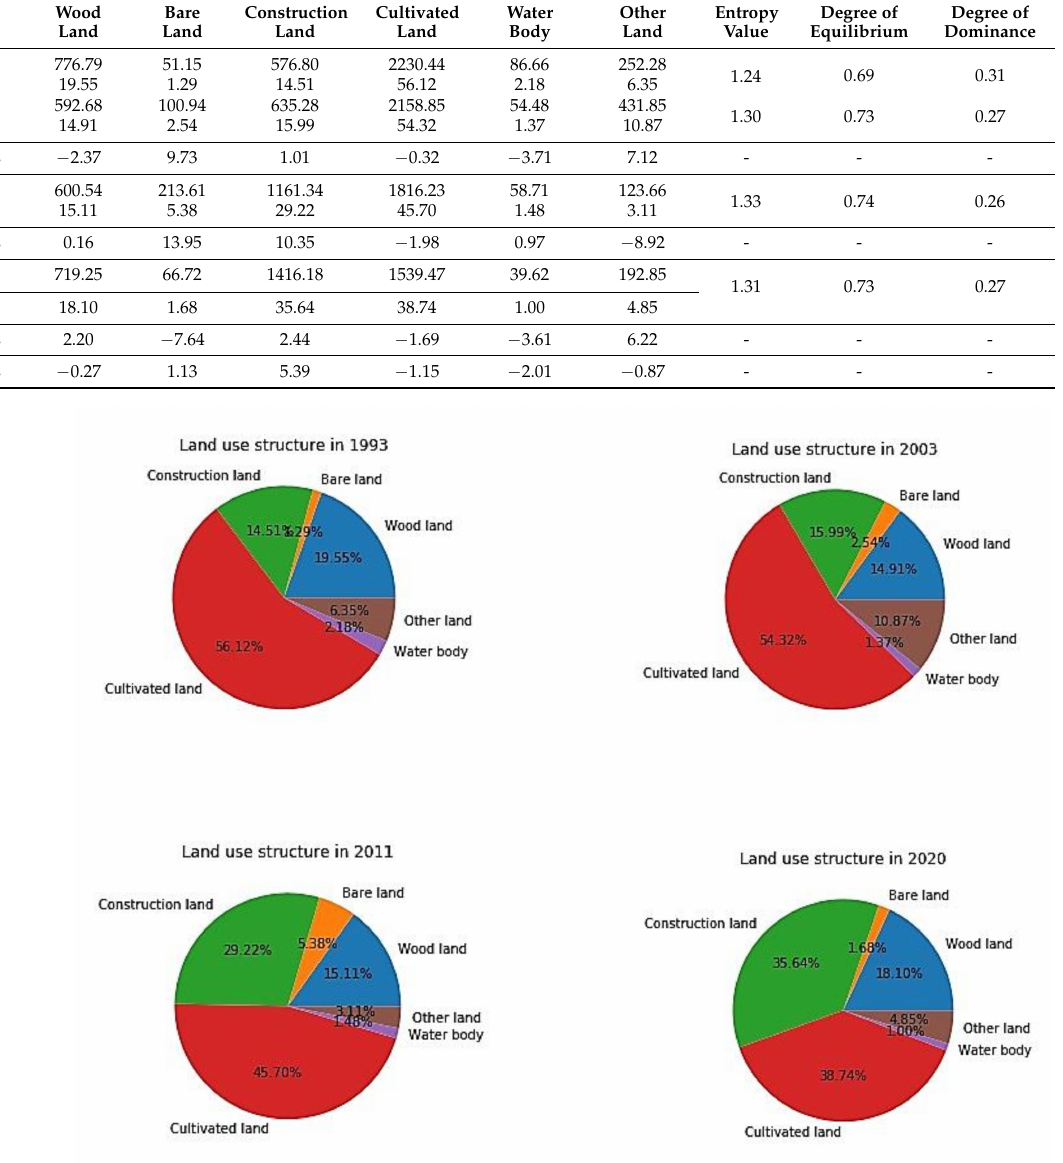
Figure 7. Land use structure in